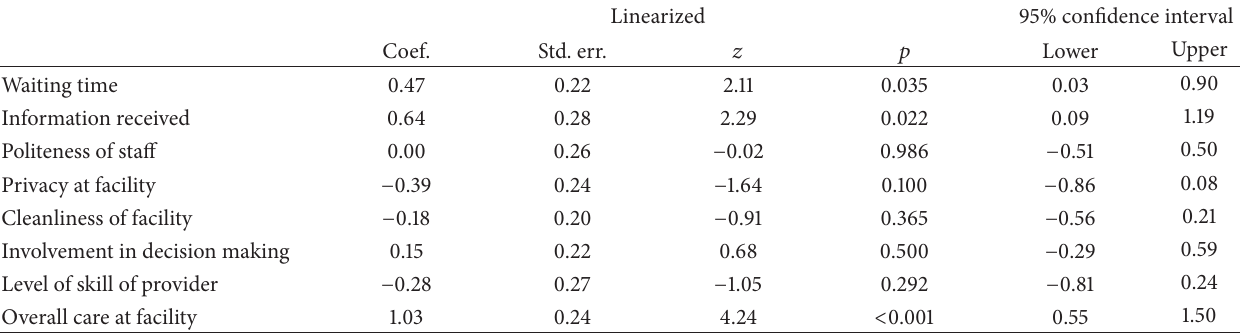
Table 4: Determinants of willingness to return to facility ( 𝑁 = 447